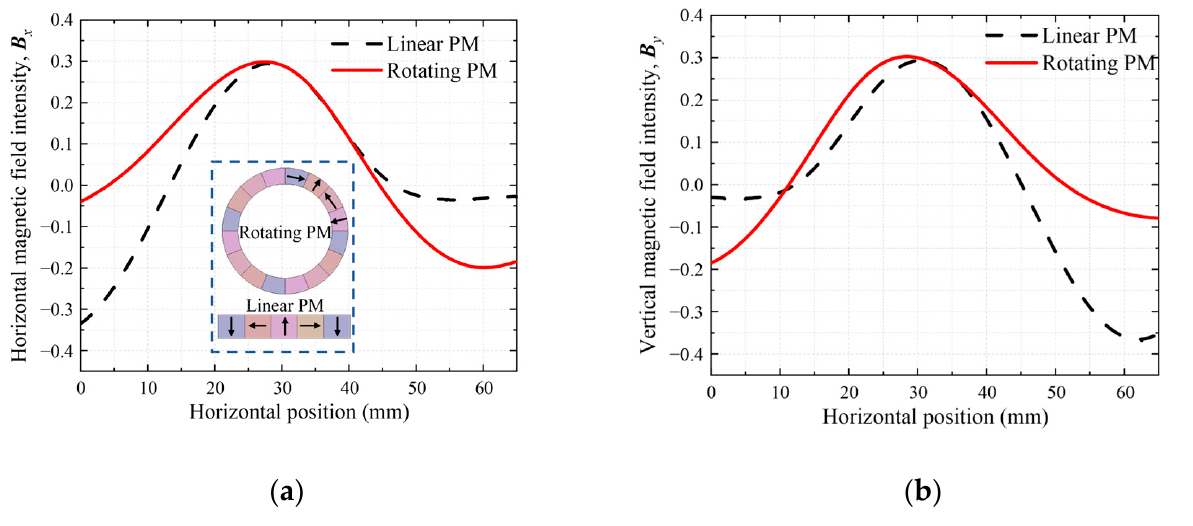
Figure 17. Magnetic field intensity at 10 mm vertical projection of PM: ( a ) Horizontal magnetic field intensity distributions; ( b ) Vertical magnetic field intensity distributions. Table 4. The specific design parameters of the annular PM EDS experimental prototype.